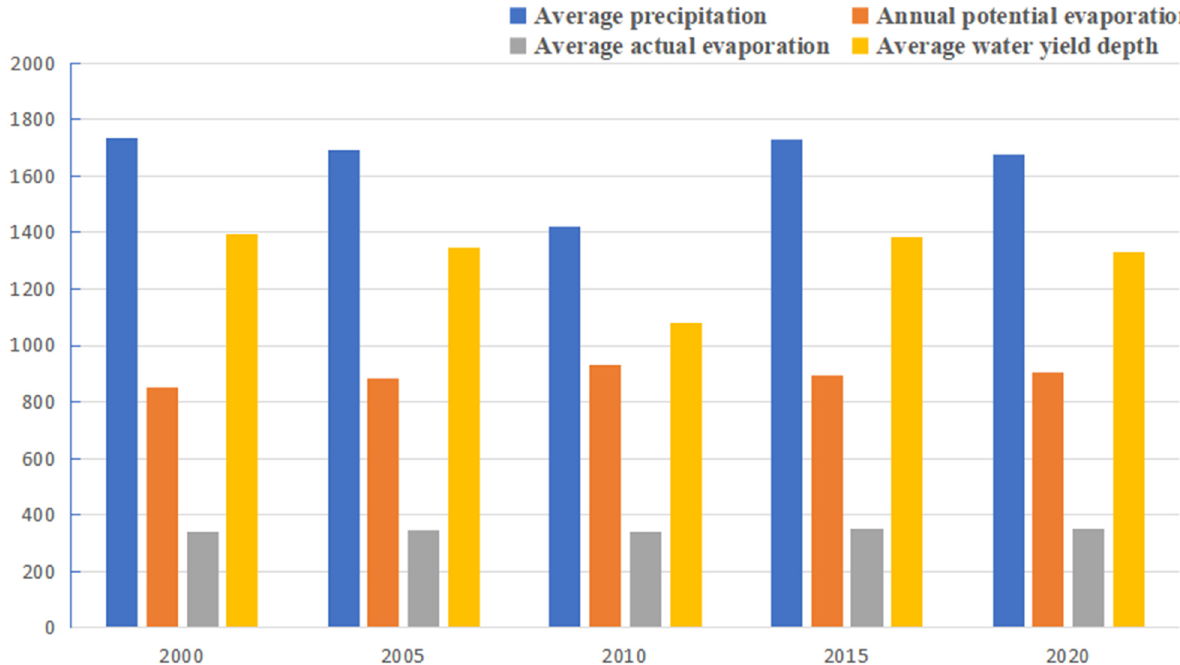
Figure 3. Changes in mean annual precipitation, evapotranspiration, and water yield in the Dongjiang Lake Basin in 2000~2020.